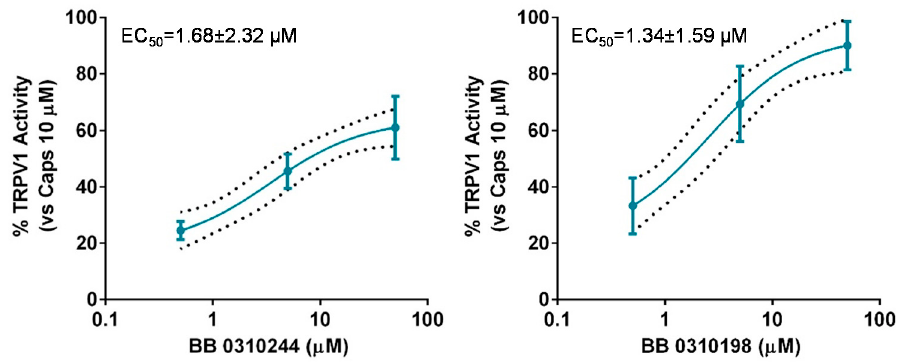
Figure 5. Dose-response curve for 13 ( BB 0310244 ) ( left panel ) and 19 ( BB 0310198 ) ( right panel ) for TRPV1 activation. Response is expressed as percentage of TRPV1 activation normalized to the effect of the prototypical agonist capsaicine at 10 μ M, considered as 100% of activation. The discontinuous line shows the 95% confidence intervals. The solid line represents fits of the experimental data to the following equation: Y = Bottom + (Top − Bottom)/(1 + 10^((LogEC50-X) ∗ HillSlope)), with the restriction of the minimum (Bottom = 0).EC50 = 1.69 (0.26–10.73) μ M with r 2 = 0.82 and Hill Slope = 0.53 for 13 ( BB 0310244 ) and EC50 = 1.34 (0.49–3.62) μ M with r 2 = 0.85 and Hill Slope = 0.67 for 19 ( BB 0310198 ).